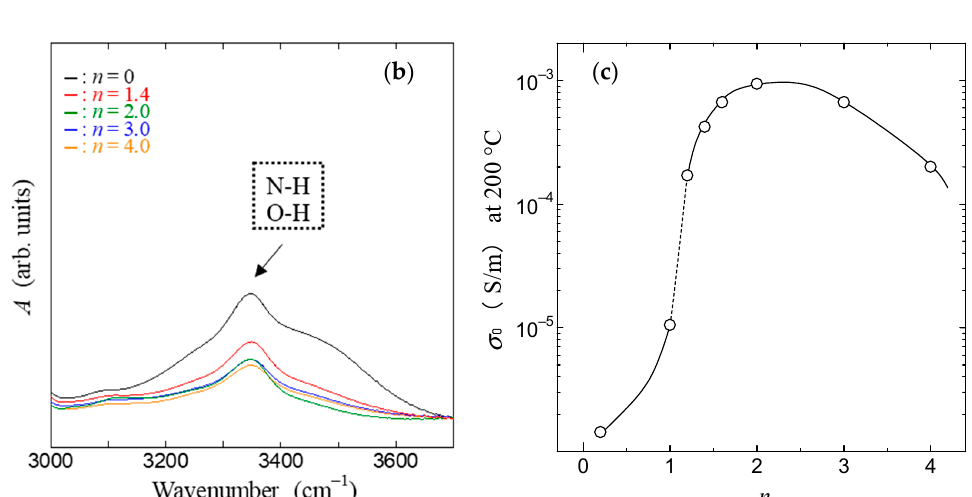
Figure 10. Proton-conductivity pathway in the imidazole–collagen composite ( n = 2.0). ( a ) Sche- matic of the imidazole-collagen composite. ( b ) Proton conduction pathway of activated imidazole- collagen composite.